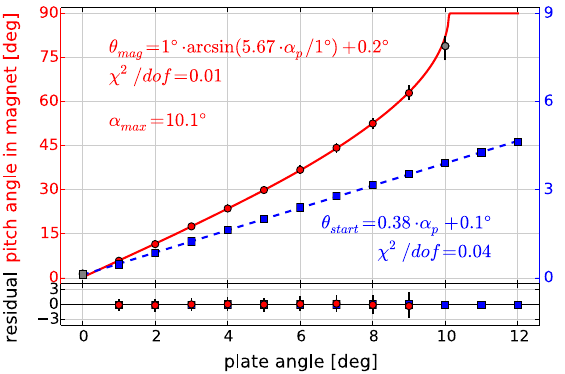
Fig. 15 Simulated pitch angle distributions at different plate angles α = 0 ◦ − 10 ◦ . The plot shows the produced pitch angles in the spec- p trometerentrancemagnet,usingsamedatasetasinFig.14.The vertical lines at the bottom mark the median pitch angle of each distribution. For θ → 90 ◦ the distribution becomes asymmetric because of magnetic reflection